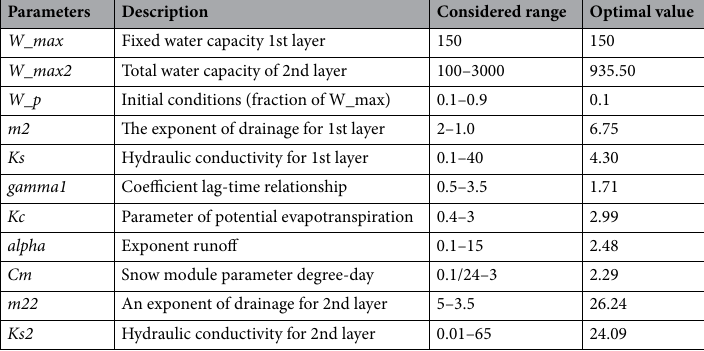
Table 5. Parameters setting for implementing MISD model.